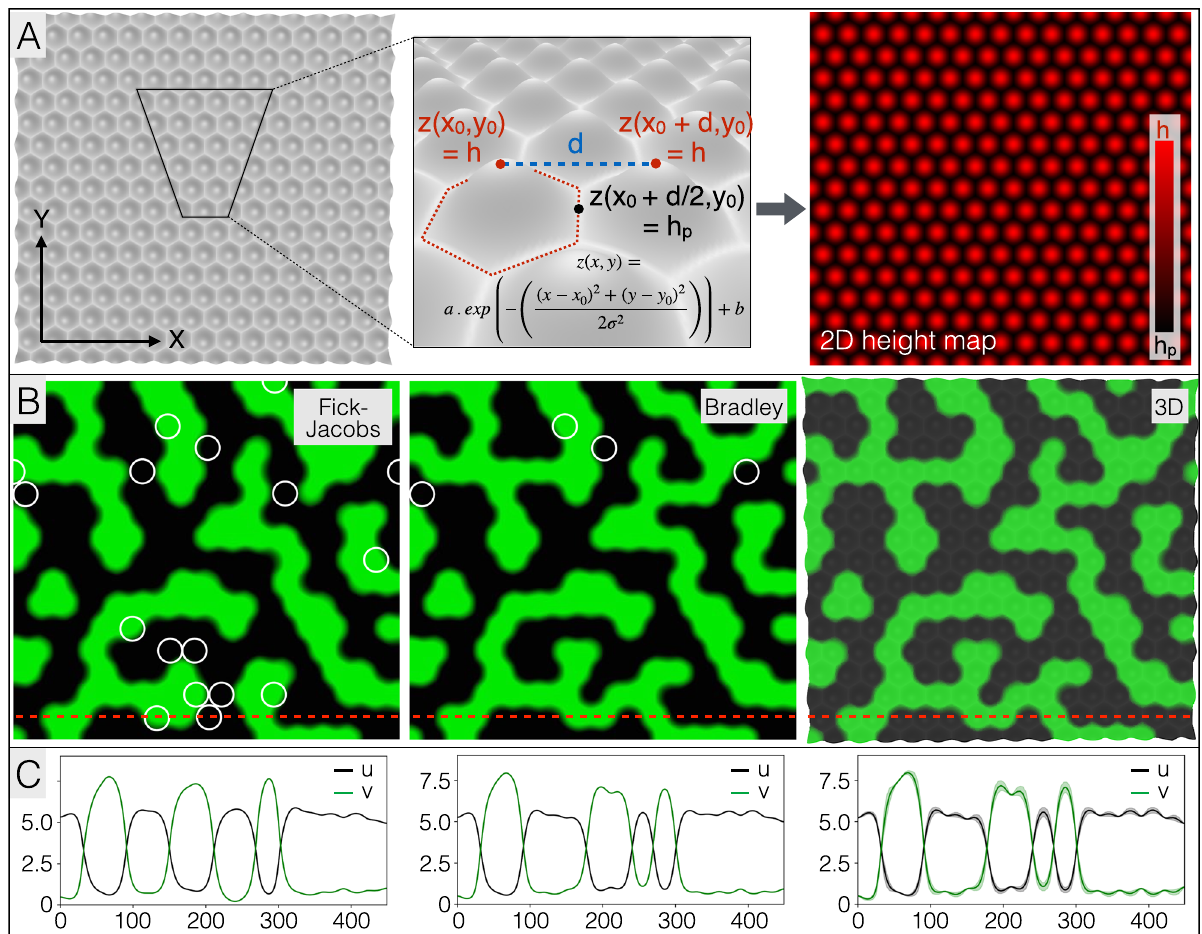
Fig. 4 Dimensionality-reduction is accurate and computationally ef fi cient. A A parametrised hexagonal lattice of 3D scales (two left panels) is generated by using, for each scale, the two-dimensional Gaussian function (inset) with heights of scales centres h and scales borders heights h p; the domain surface geometry is produced by fi tting the constants a and b of the Gaussian function and keeping the standard deviations identical in the X and Y directions ( σ X = σ Y , symmetrical Gaussian bumps). The height information (right panel) is then used to perform 2D simulations with two different dimensionality- reduction approaches. B Starting with identical initial conditions, 2D-reduced simulations (with h p/ h = 0.31) on a lattice of 450 × 417 elements with the Fick – Jacobs (left panel) and Bradley (central panel) methods, as well as 3D simulations (right panel), produce qualitatively very similar steady-state scale- by-scale patterns. Individual scales (white circles) with colour states opposite to those observed in the bona fi de 3D simulation (green or black instead of black or green) amount to 6.4 and 1.5% of the scales for the Fick – Jacobs and Bradley methods, respectively. Parameter values are ɛ = 3, σ = 8, h = 16, D u = D = 11.25 and D = 135. C Pro fi les of components ’ concentrations are shown for the y coordinate indicated by the red dotted lines in the corresponding v w panels in ( B ); shades in right panel are minimum-maximum concentration intervals in the z direction (plain line is the